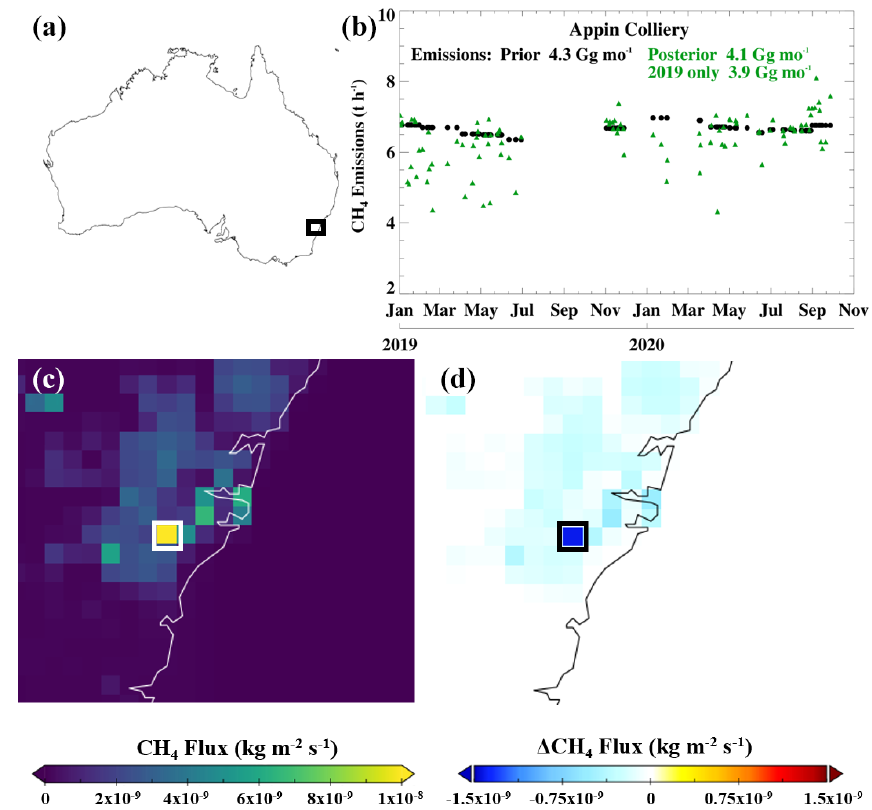
Figure 6. (a) A map of Australia with the Appin colliery domain indicated by the black box. (b) Time series of prior (black circles) and posterior (green triangles) fugitive CH 4 emission estimates within the domain for 2019–2020, excluding days for which observations were not available. (c) Average prior CH 4 emissions for 2019, the white box denotes the grid cell used to estimate emissions. (d) Average posterior minus prior CH 4 emissions for January–June 2019, excluding days for which observations were not